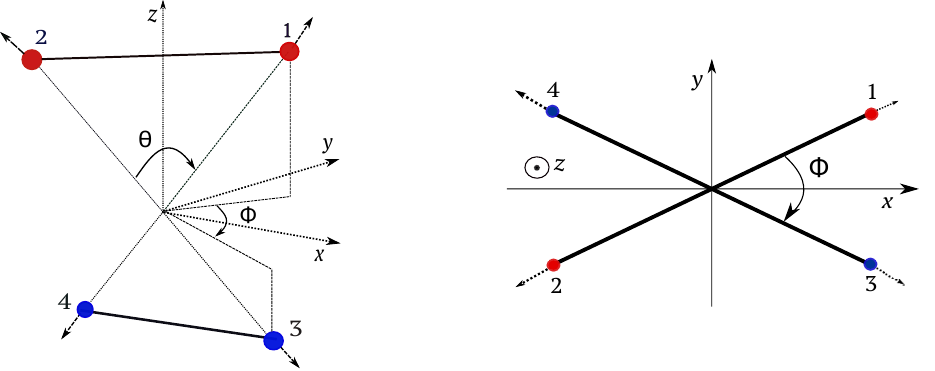
Figure 5 . Schematic diagrams of two strings in their parallel frame. On the left, θ is the opening angle between the partons constituting each string, while on the right we show the skewness angle, φ in the projection on the x − y -plane of the two string